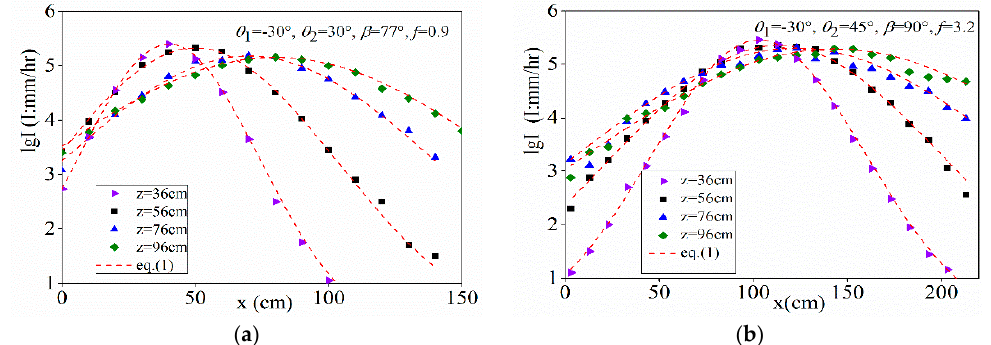
Figure 8. Rainfall intensity distributions along the x -axis and comparison with Equations (1) and (2). ( a ) θ 1 = − 30°, θ 2 = 30°, β = 77°, and f = 0.9; ( b ) θ 1 = − 30°, θ 2 = 45°, β = 90°, and f = 3.2.